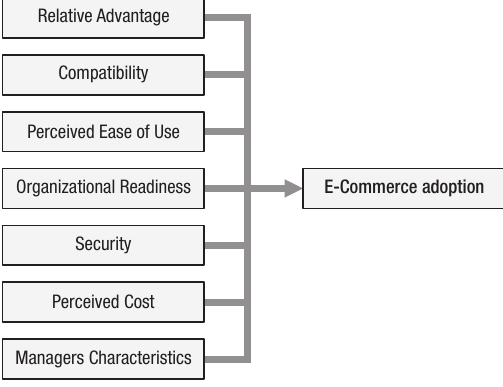
Fig. 1. Research Model